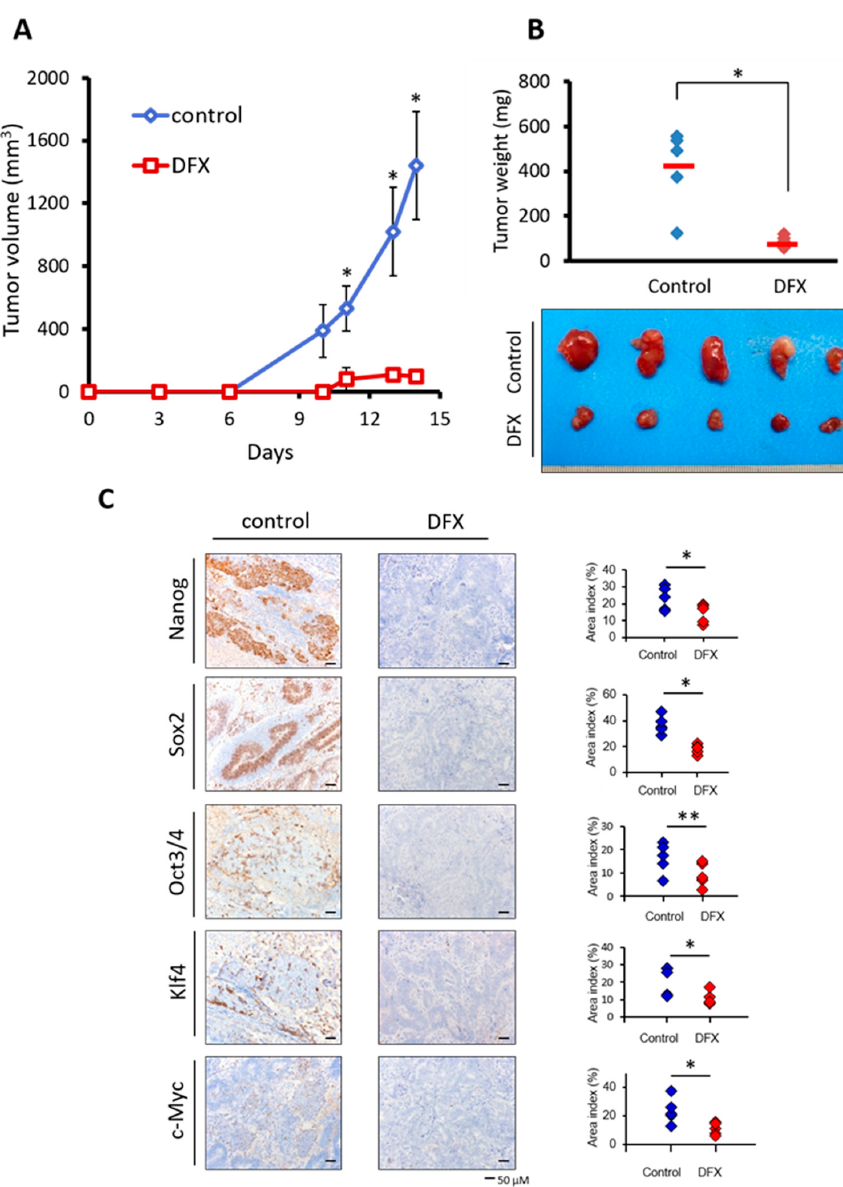
Figure 2. DFX suppressed tumorigenicity and expression of stemness markers in miPS cells in vivo.